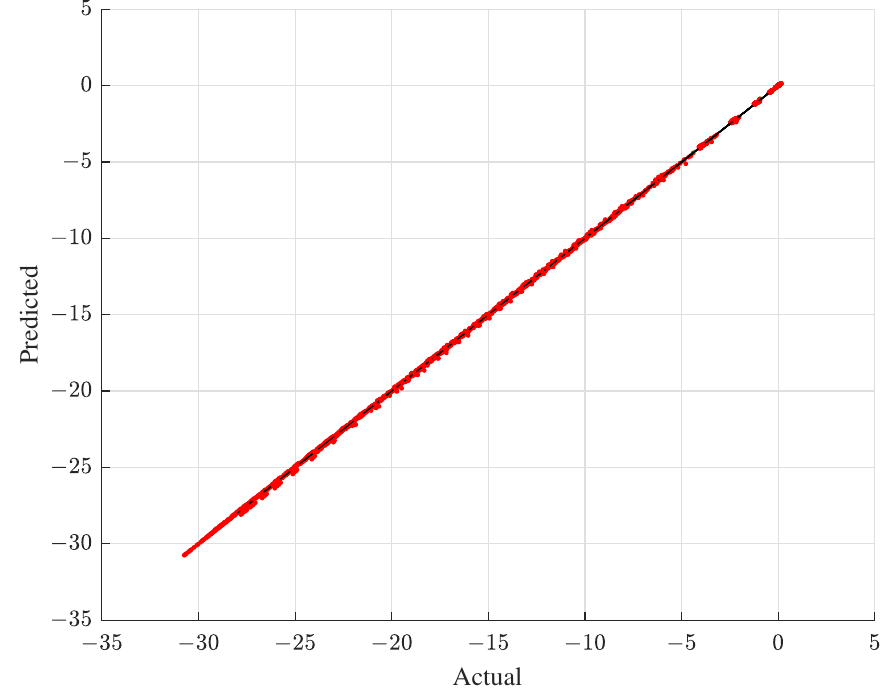
Figure 12. Actual versus predicted EMF simulation output with the testing data.